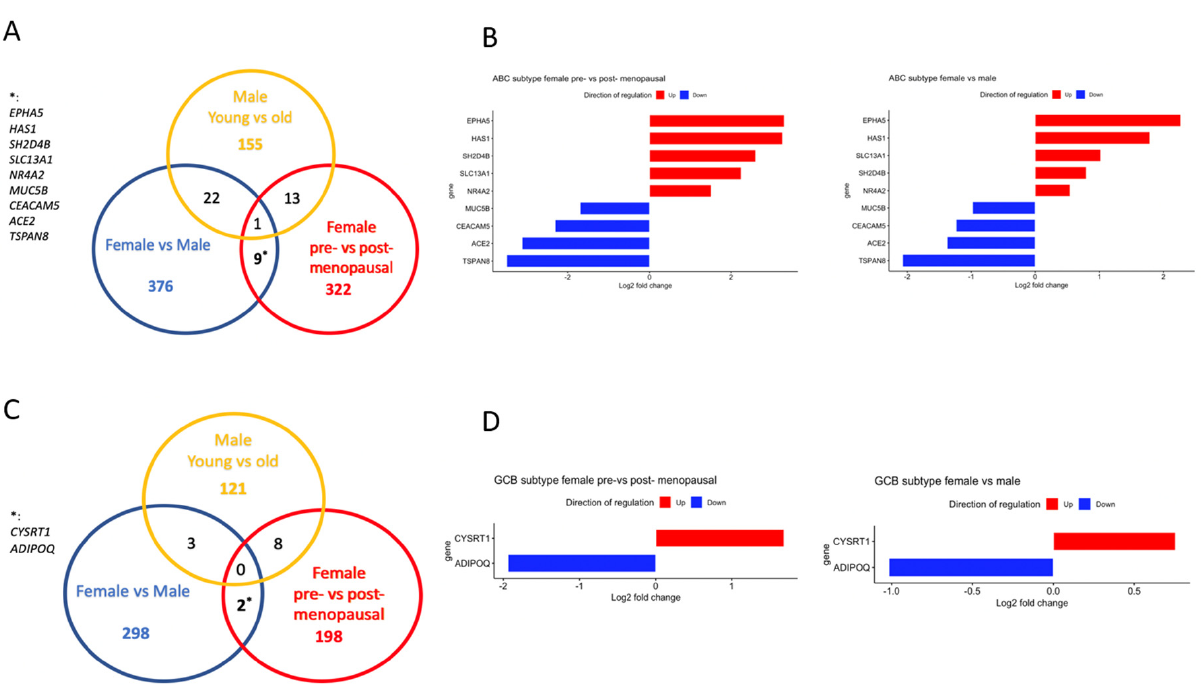
Figure 4. Identification of genes that likely are regulated by estrogens in the ABC and GCB DLBCL subtypes, respectively. ( A ), Venn diagram showing the overlap of differentially expressed genes in the ABC DLBCL subtype. ( B ), Bar graph showing the log2-fold change of genes that are likely regulated by estrogen in the ABC subtype. Upregulated genes are marked in red, and downregulated genes are marked in blue. ( C ), Venn diagram showing the overlap of differentially expressed genes in the GCB DLBCL subtype. ( D ), Bar graph showing the log2-fold change of genes that are likely regulated by estrogens in the GCB subtype. Upregulated genes are marked in red, and downregulated genes are marked in blue.